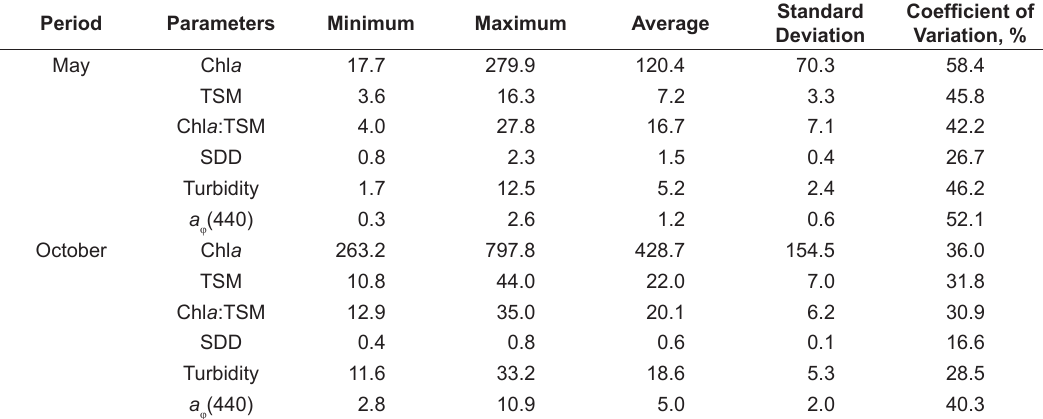
Table 1. Descriptive statistic of chl a in mg m -3 , TSM in g m -3 , Chl a :TSM in mg g -1 , SDD in m, turbidity in NTU and a in m -1 φ